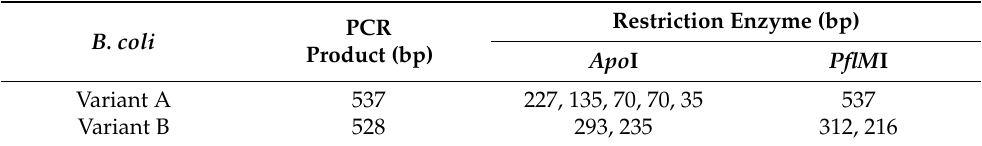
Table 1. Polymerase chain reaction-restriction fragment length polymorphism (PCR-RFLP) results of Balantioides coli variants A and B digested with restriction enzymes Apo I and PflM I.